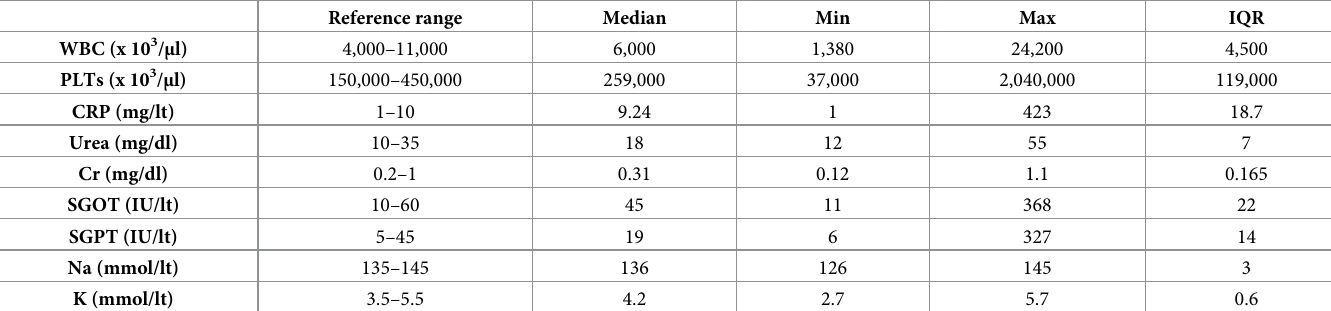
Table 2. Laboratory parameters of hospitalized children diagnosed with measles in Athens 8/2017-10/2018 (n =